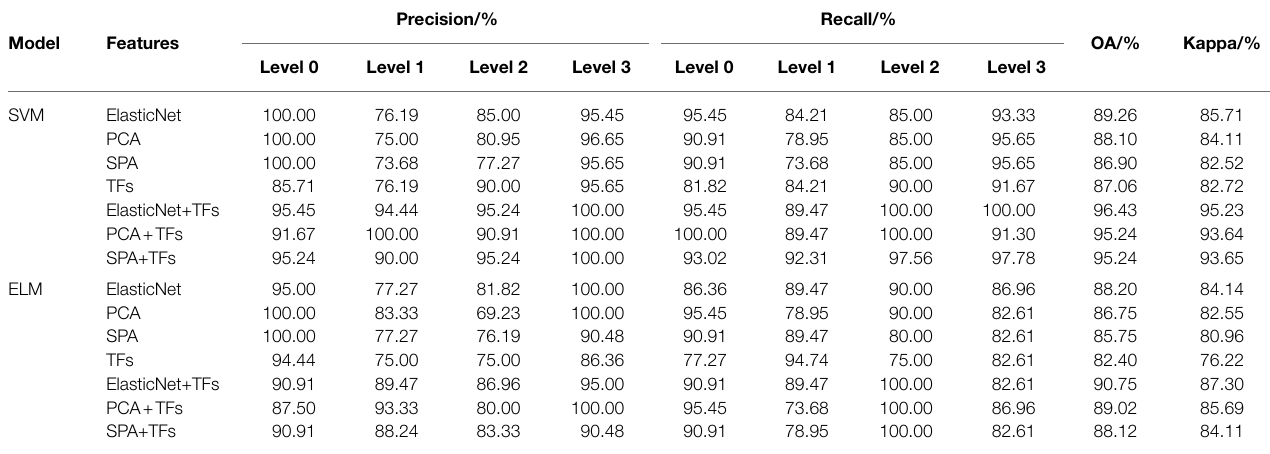
TABLE 8 | Modeling results of SVM and ELM.